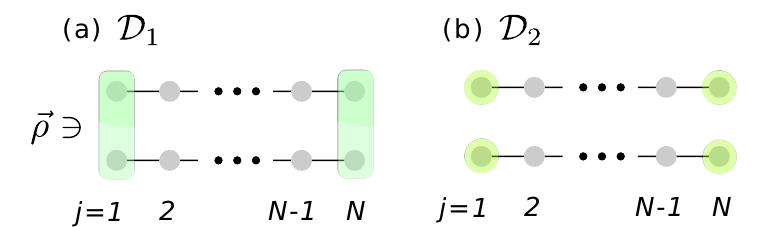
Figure 2: Schematic illustration of matrices (a) D scheme of ρ → (cid:126)ρ ∈ H ⊗ H . The upper (lower) chain corresponds to the left (right) part of H ⊗ H . The colored sites show nontrivial actions of parts of D Eqs.